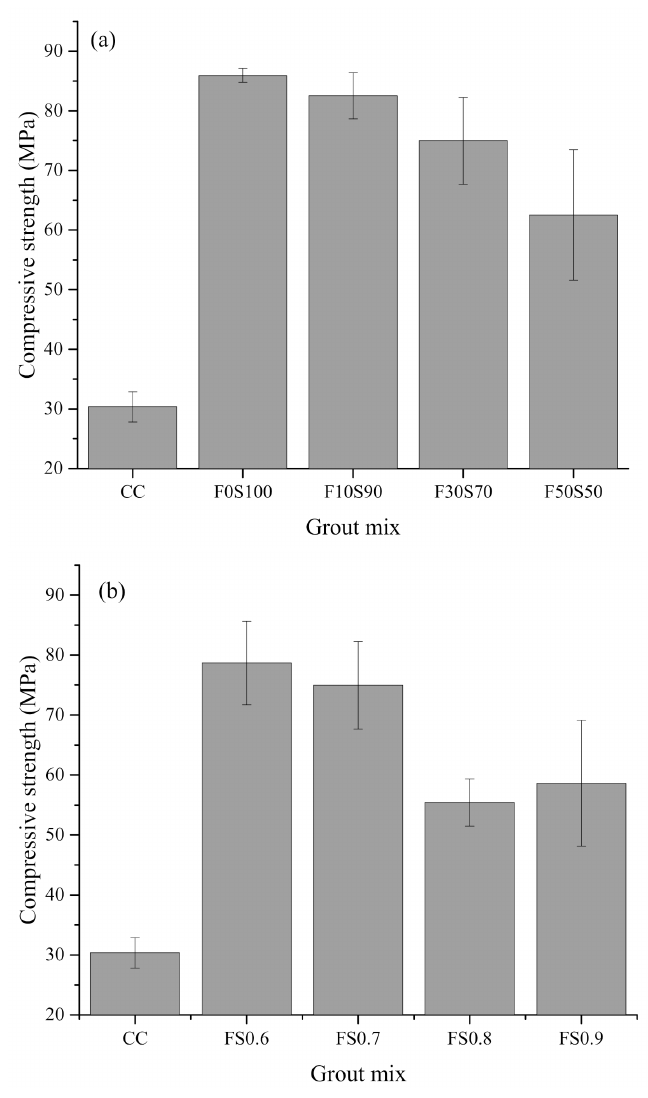
Figure 4. Compressive strength of grout mixes: ( a ) Series 1 and ( b ) series